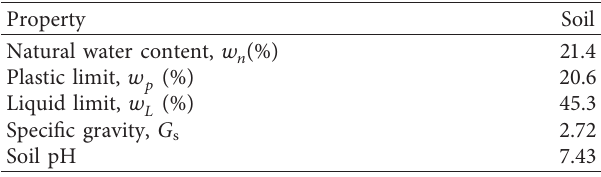
Table 1: Properties of soil used in this study. Property Soil